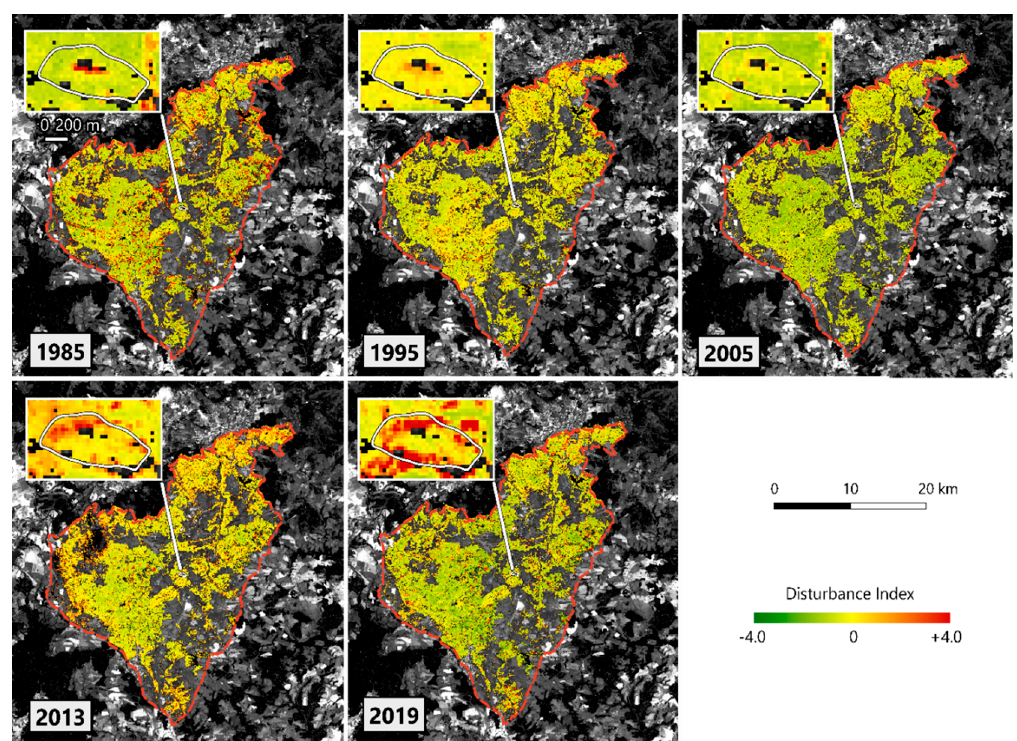
Figure 8. Decennial changes in Landsat-derived disturbance index computed for the Slavkov Forest protected landscape area (protected since 1974), with detailed insight into the PLB catchment. Note that the increased value of DI in the northwest area of the Landsat image from 2013 was due to cloud cover (there was not a single cloud-free Landsat image available for the entire area around 2013).